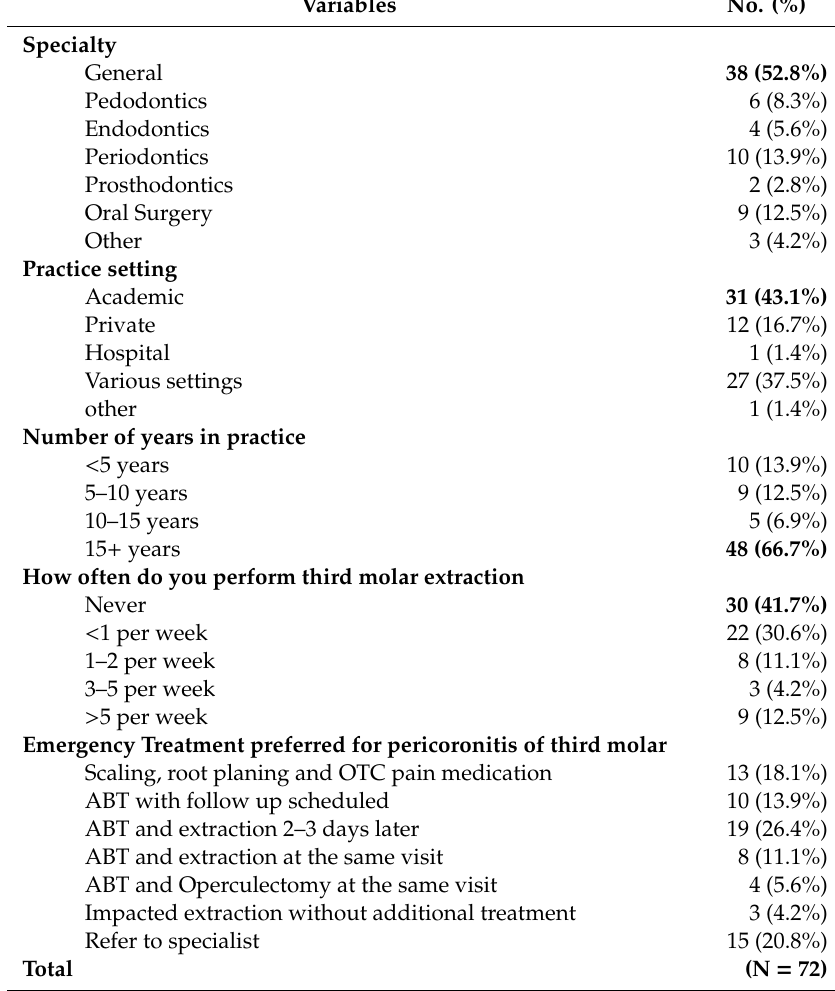
Table 1. Descriptive frequency of answers for selected questions in the